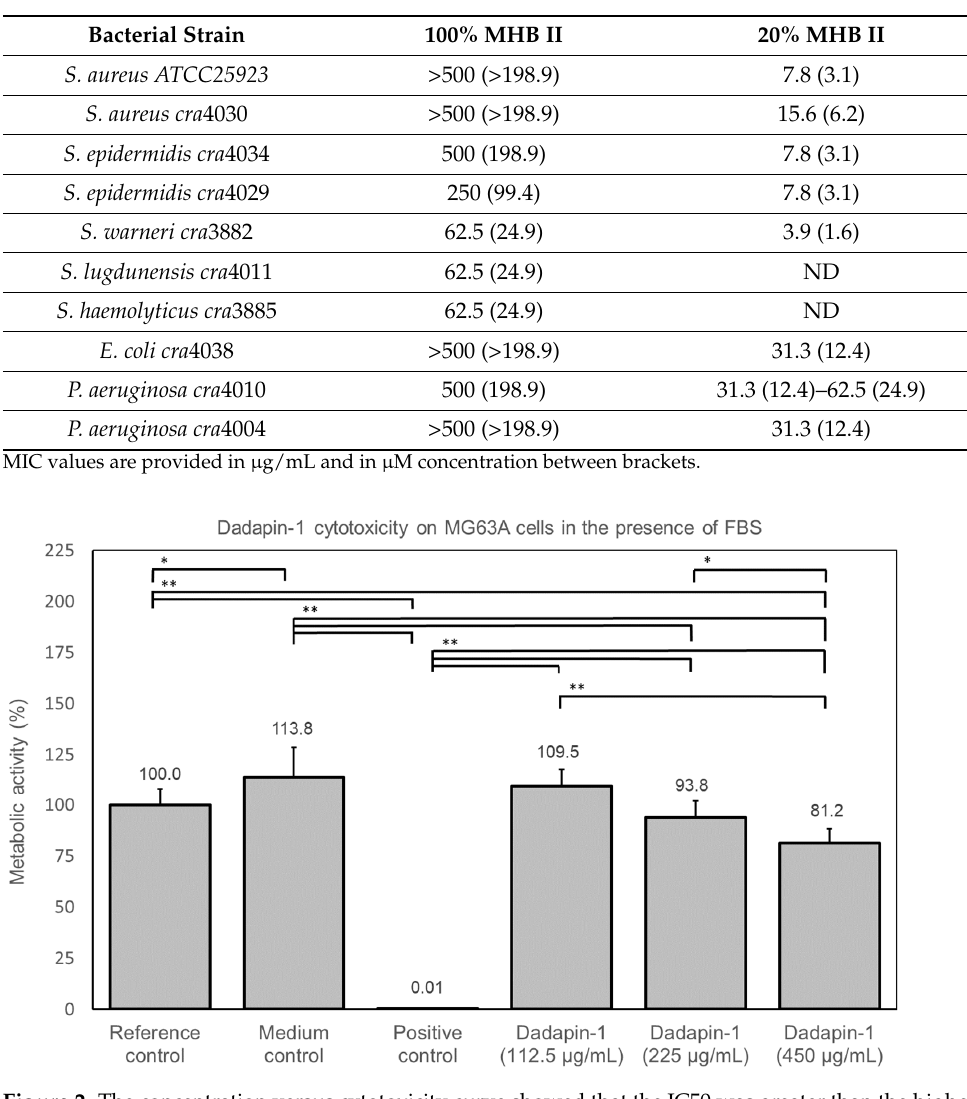
Figure 2. The concentration versus cytotoxicity curve showed that the IC50 was greater than the highest Dadapin-1 concentration tested. Therefore, this bar graph reports just the metabolic activity observed in the MG63 after the treatment with the three highest investigated concentrations of Dadapin-1. The RLU values of the luminescence assay were normalized with respect to the reference control, which was equated to 100%. For the different controls, the bars report the mean ± S.D. of 12 measurements and for Dadapin-1 treatments of 9 measurements from three independent experiments. The data were statistically analyzed by ANOVA followed by Bonferroni/Dunn test. Comparisons are not significant unless p < 0.0033. Legend: *, p = 0.0004; **, p < 0.0001.